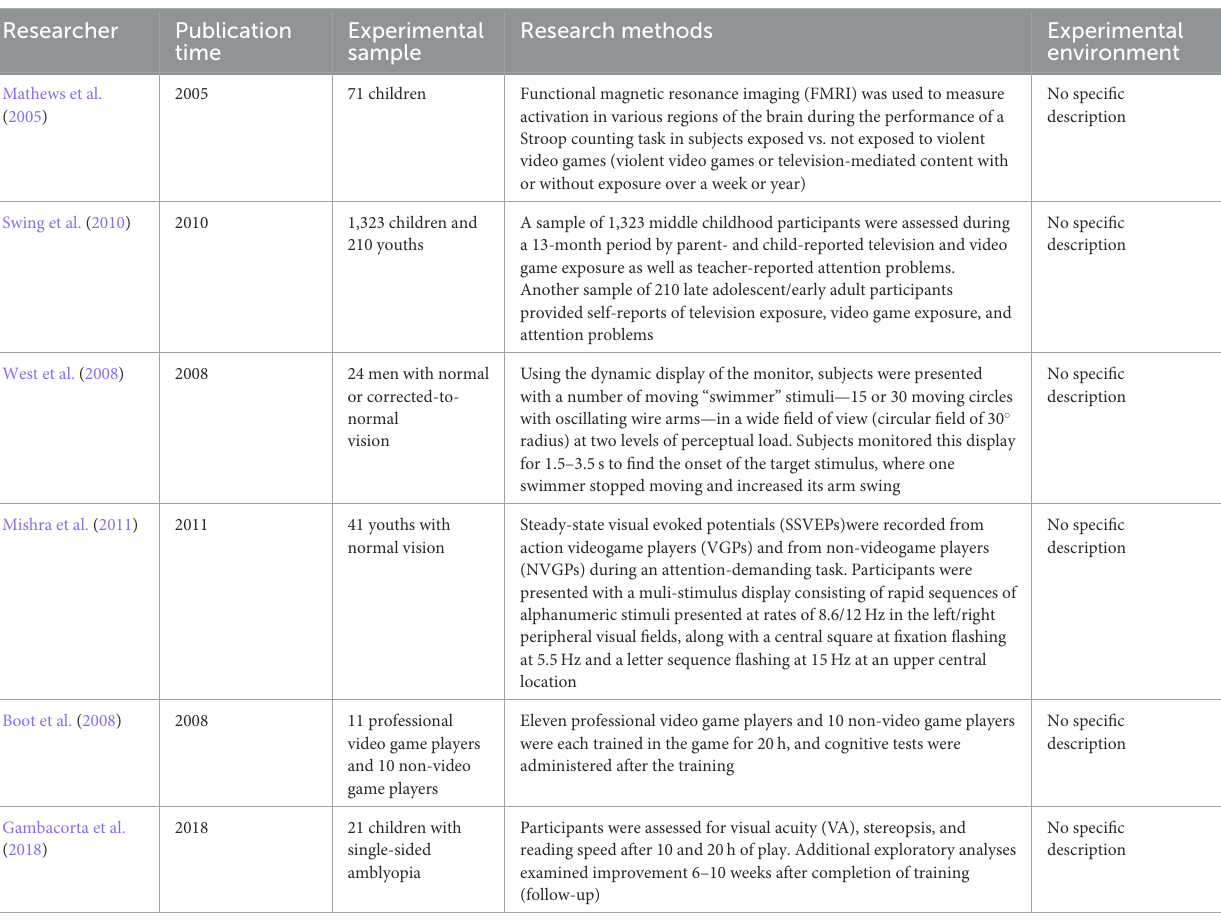
TABLE 1 Research on the relationship between video game training and